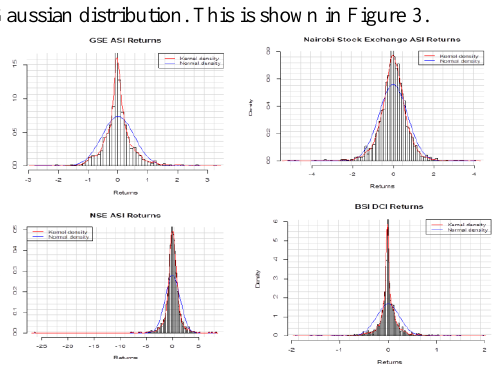
Figure 3. Histograms of Log-Returns with Kernels and Normal Density Curves Superimposed